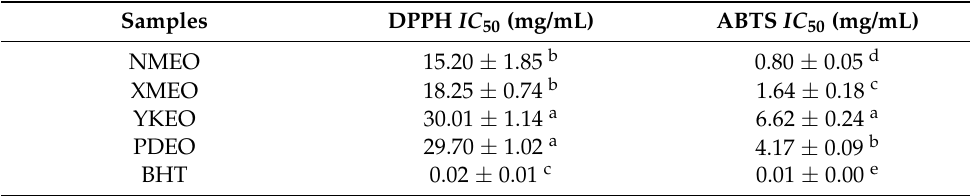
Table 4. Antioxidant activities of citrus EOs by DPPH and ABTS